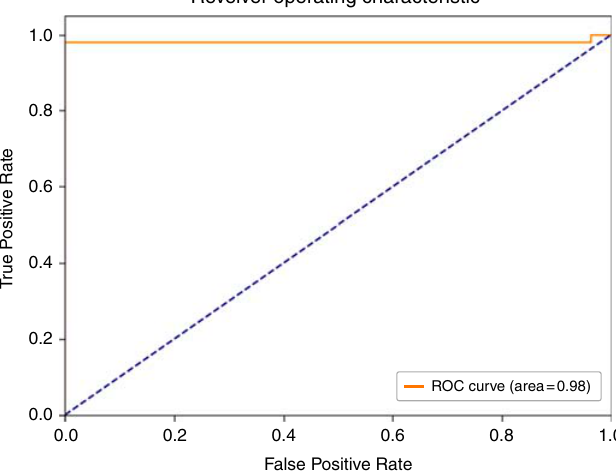
Figure 4. As seen on the curve, our convolutional neural network classifier has a high AUROC score of